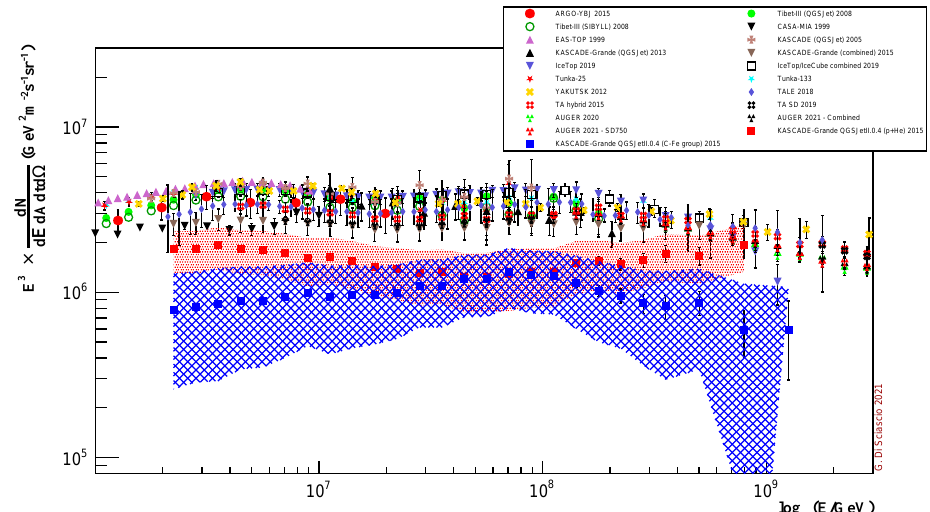
Figure 8. The all–particle energy range in the ’transition’ region measured by different experiments. The light and heavy components measured by KASCADE–Grande are also